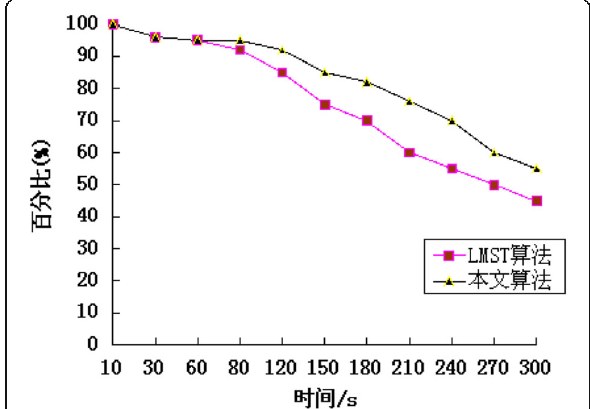
Fig. 4 Comparison of network node delivery rate curves between this algorithm and LMST